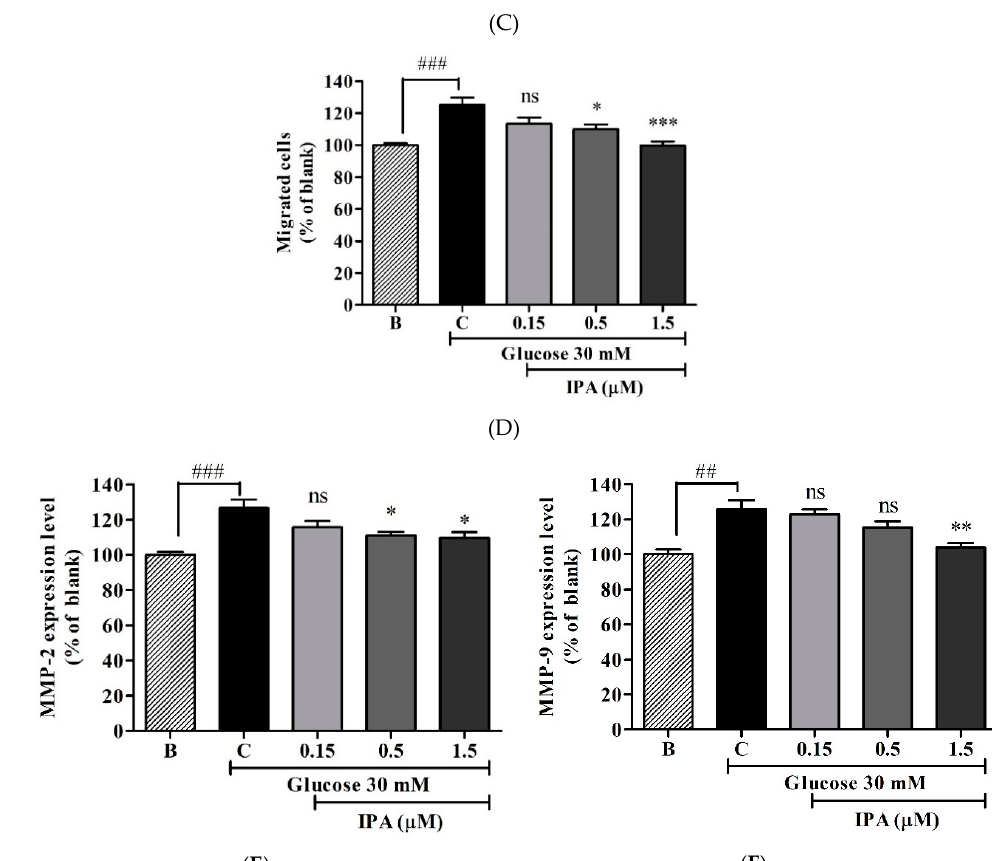
Figure 4. ( A ) IPA inhibits high glucose-induced cell migration. The cells were treated with different concentrations of IPA (0.15, 0.5, and 1.5 µM), along with 30 mM glucose. The cell monolayer was scraped at the middle of the well, and the initial gap length (0 h) and the final gap length (12 h) was measured. ( B ) The gap closure was quantified by percentage (%). ( C ) IPA inhibits cell migration through transwell filter chambers. The migrated cells were fixed, stained, and counted. ( D ) Quantification of migrated cells through transwell filter chambers. Matrix Metalloproteinase (MMP) (MMP-2 and -9) expression levels were evaluated using commercial Enzyme-Linked Immunosorbent Assay (ELISA) kits. ( E ) Quantification of MMP-2 expression. ( F ) Quantification of MMP-9 expression. The effects of 30 mM glucose on cell migration/MMP expression levels were compared to B (blank (0 mM glucose + 0 µM IPA)), and the effects of IPA on high glucose-induced cell migration/MMP expression level were normalized to C (control (30 mM glucose + 0 µM IPA)). Scale bar (A) and (C) 1000 µ m. ns; not significant, * p < 0.05, ** p < 0.01, *** p < 0.001, ## p < 0.01, ### p <